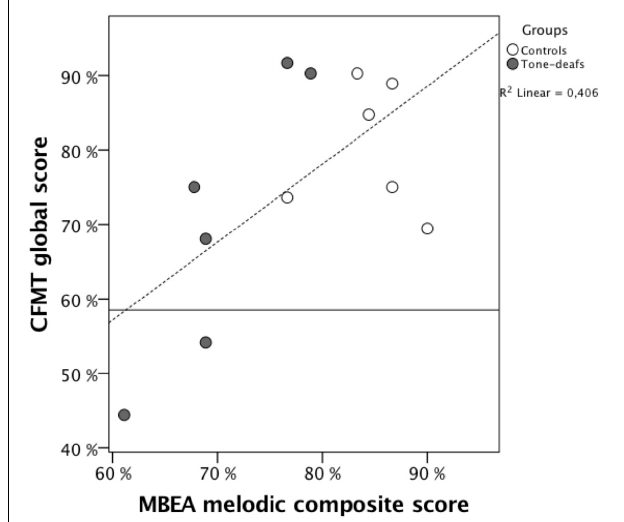
FIGURE 1 | Representation of the participants CFMT global scores ( Y ) and MBEA melodic composite score ( x ) presented by groups: Tone-deaf subjects (black) and control subjects (white). The horizontal line represents the CMFT cut-off presented in text.